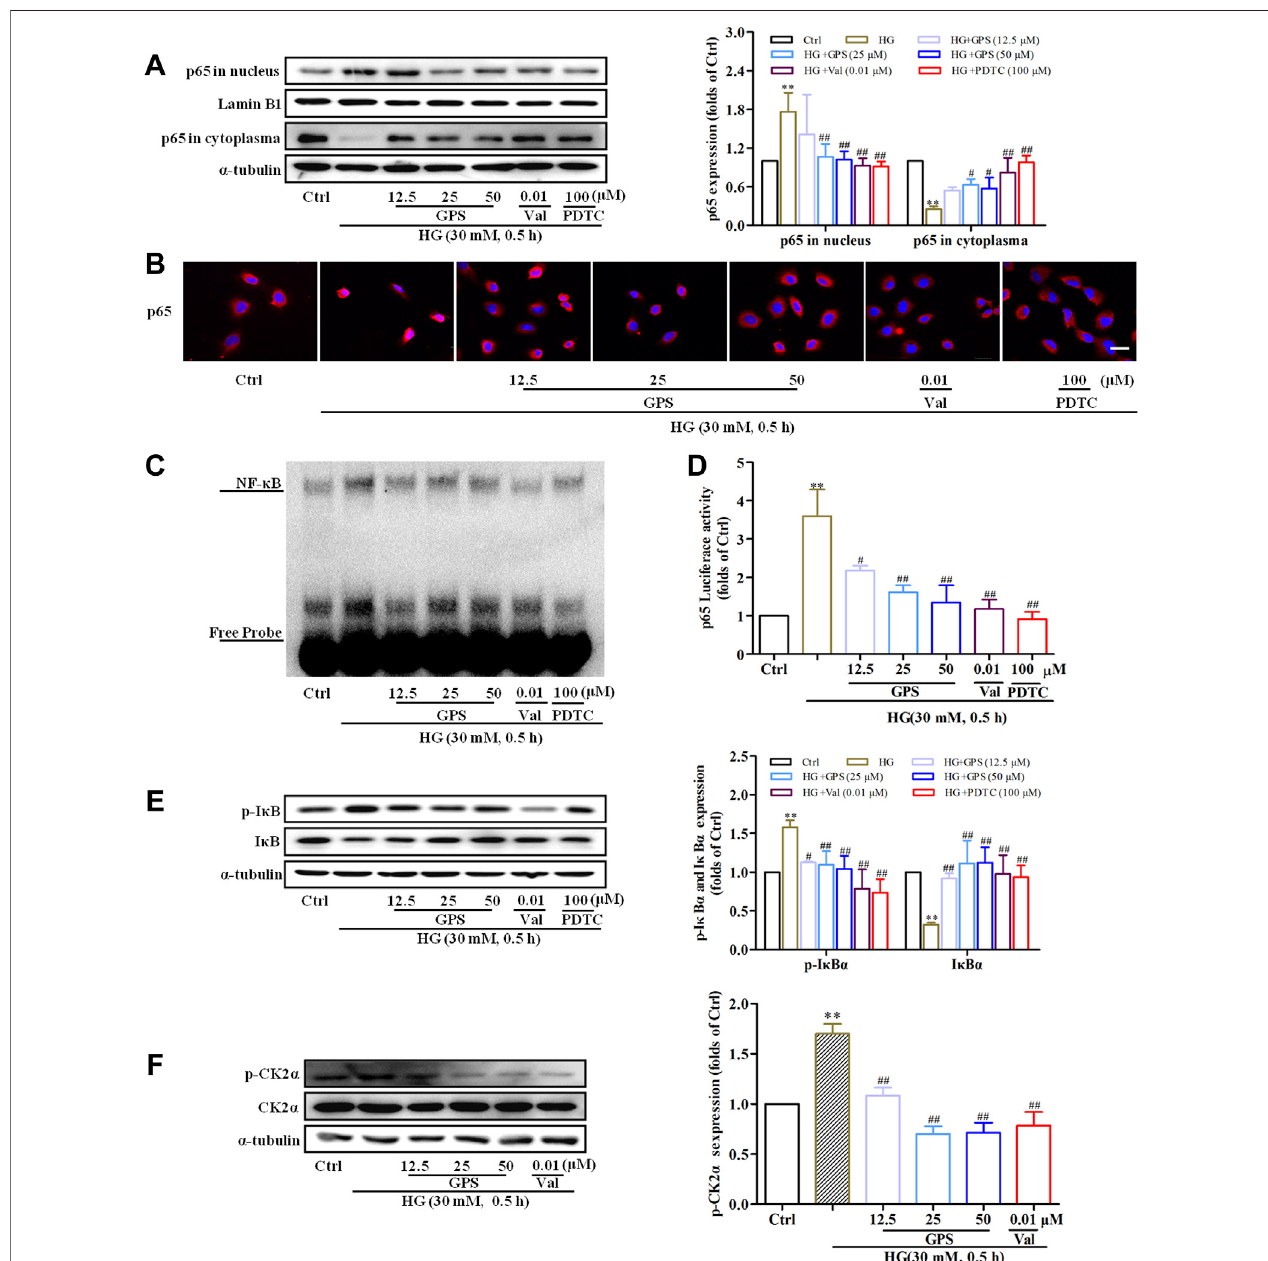
FIGURE6| GPSinhibitedHG-inducedactivationoftheCK2/NF- κ BpathwayinNRK-52Ecells. (A) EffectsofGPSonp65distributioninthenucleusandcytoplasm weredetectedbyWesternblot.** p < 0.01 vs .Ctrl. ## p < 0.01and # p < 0.05 vs .HG. (B) EffectsofGPSonp65distributioninthenucleusandcytoplasmweredetectedby immuno fl uorescence. Scale bar: 20 μ m. (C) Effect of GPS on the NF- κ B p65 DNA binding activity was detected by EMSA. (D) Effect of GPS on the NF- κ B p65 transcriptional activity was detected by luciferase reporter assay. ** p < 0.01 vs . Ctrl. ## p < 0.01 and # p < 0.05 vs . HG. (E,F) Protein levels of I κ B α , p-I κ B α , and p-CK2 α after GPS intervention were detected by Western blot. ** p < 0.01 and * p < 0.05 vs . Ctrl. ## p < 0.01 and # p < 0.05 vs . HG. ** p < 0.01 vs . Ctrl. ## p < 0.01 and # p < 0.05 vs . HG. Data were expressed as mean ± SD.